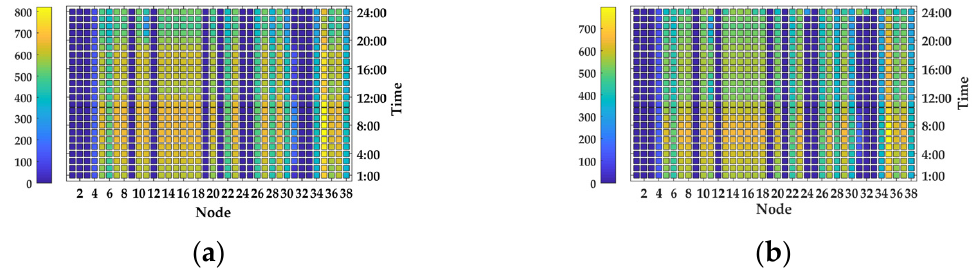
Figure 10. Temporal and spatial distribution of EV acceptance capacity in residential areas in the